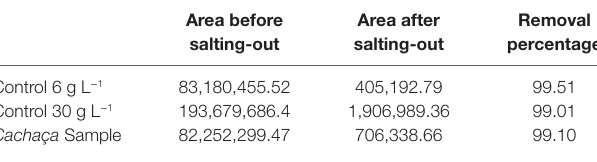
TaBle 1 | Sugar percentage removal by extracted ion chromatogram peak area.